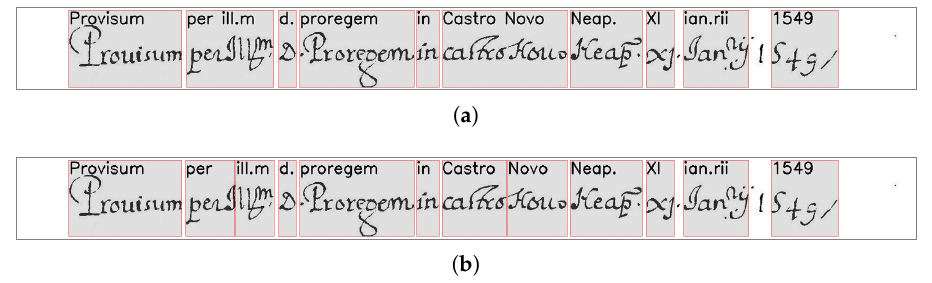
Figure 9. Examples of alignment: ( a ) the result of the original MiM algorithm; ( b ) the result of our alignment